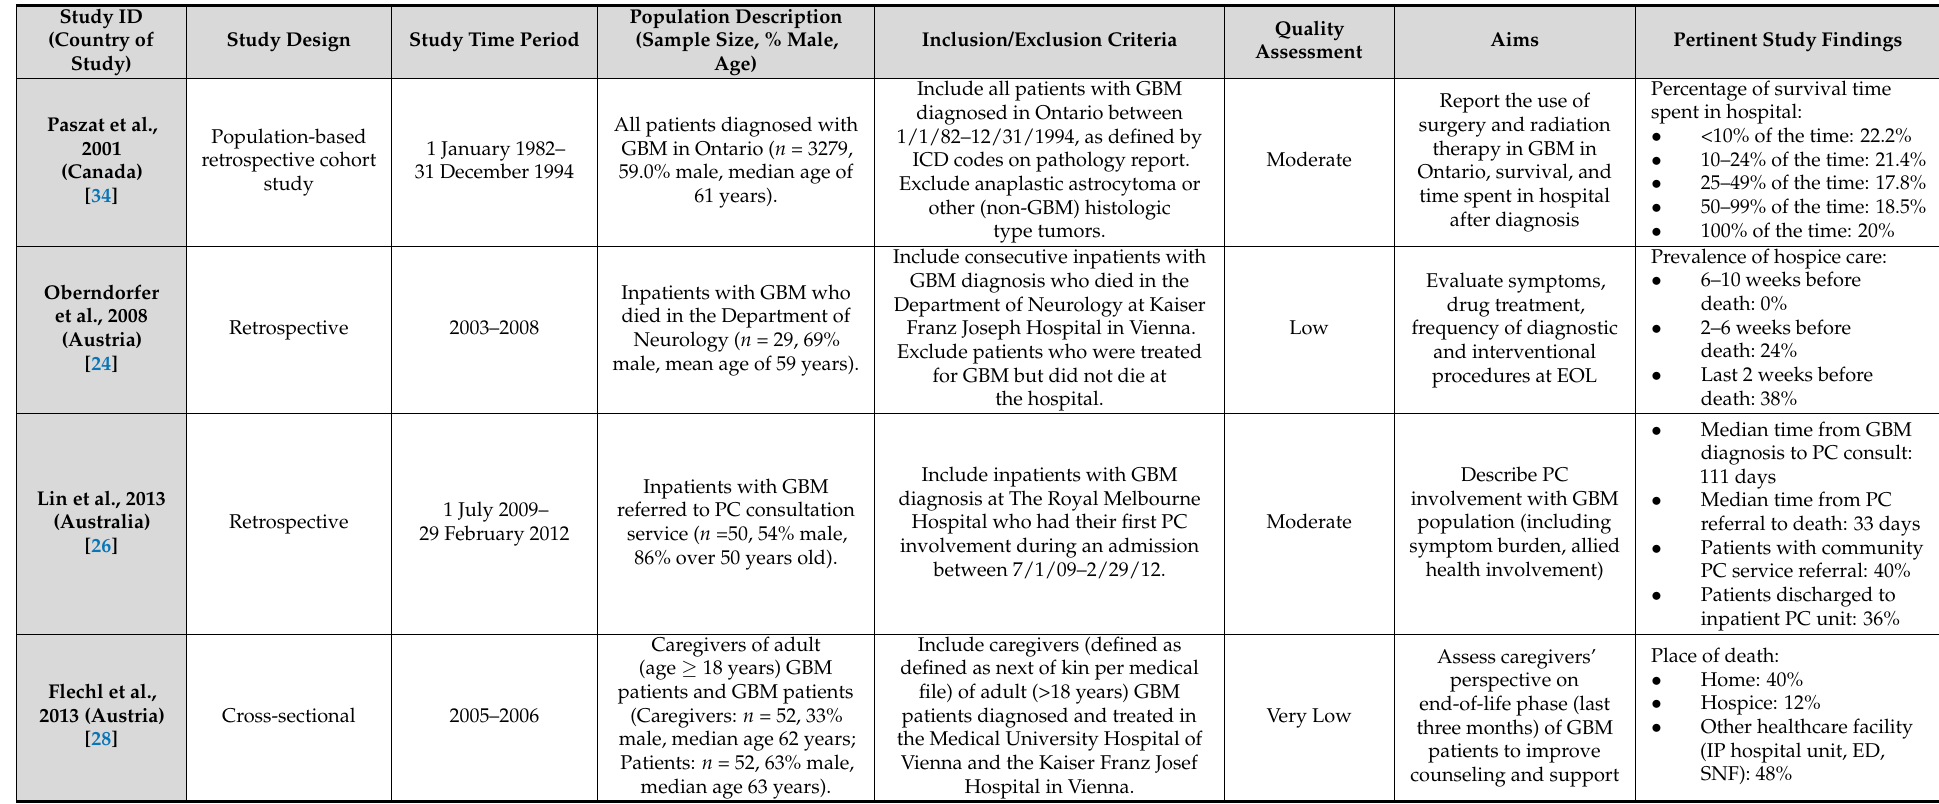
Table 1. Summary of eligible studies after